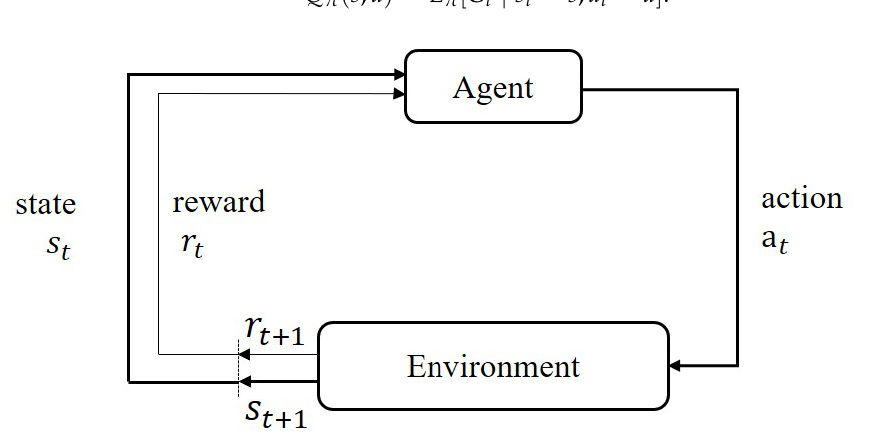
Figure 1. The interaction between the agent and the environment in